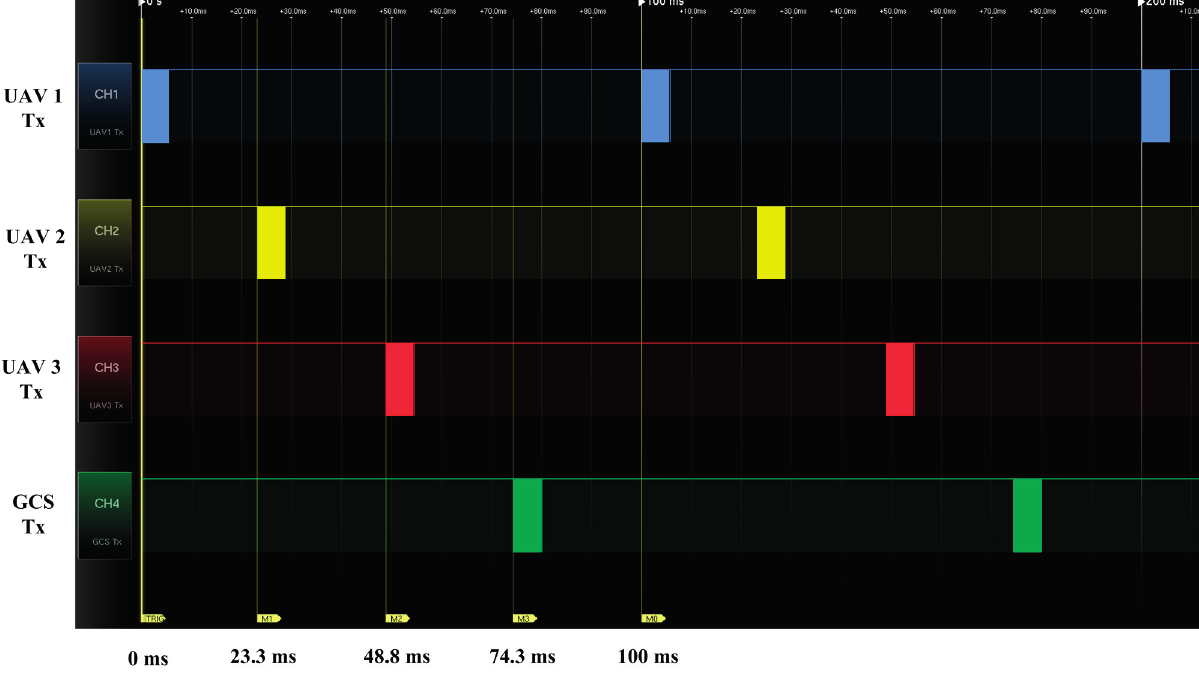
Figure 8. Timing measurement result of sequential cyclic